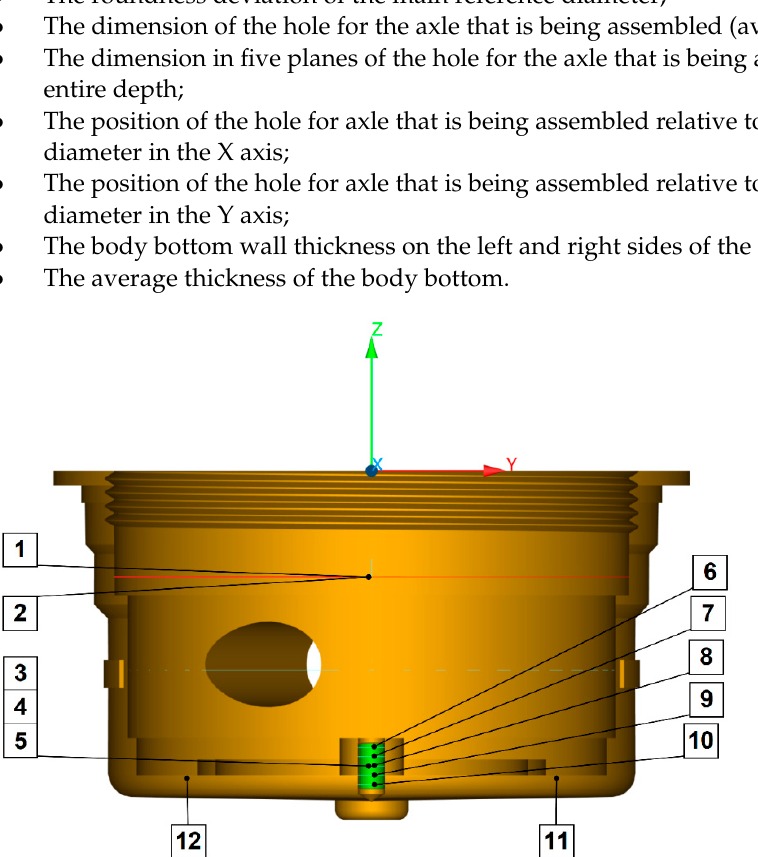
Figure 4. Parameters and input characteristics: 1—the dimension of the main reference diameter, 2—the roundness deviation of the main reference diameter, 3—the dimension of the hole for the axle that is being assembled (averaged), 4—the position of the hole for axle that is being assembled relative to the main reference diameter in the X axis, 5—the position of the hole for axle that is being assembled relative to the main reference diameter in the Y axis, 6, 7, 8, 9, 10—the dimension in five planes of the hole for the axle that is being assembled, along its entire depth, 11, 12—the body bottom wall thickness on the left and right sides of the symmetry